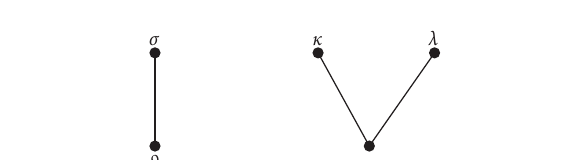
Figure 4: Figure of Θ for Example